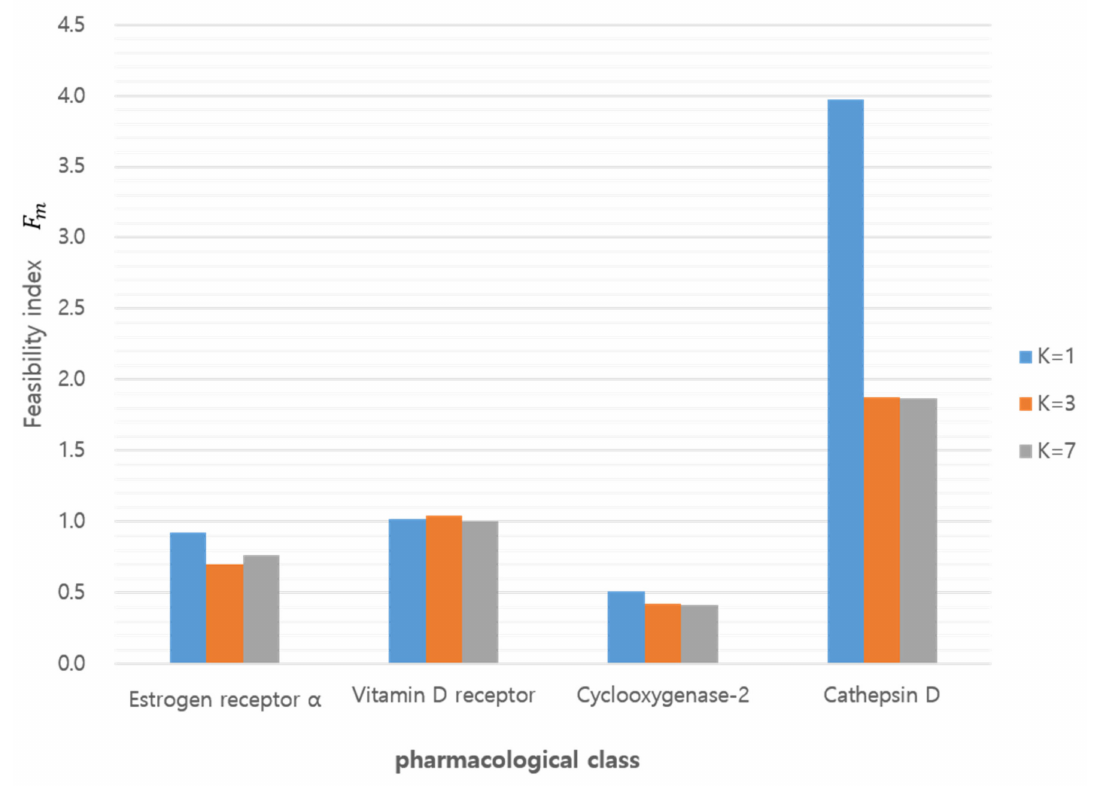
Figure 8. Feasibility index according to target class and GMM component ( K